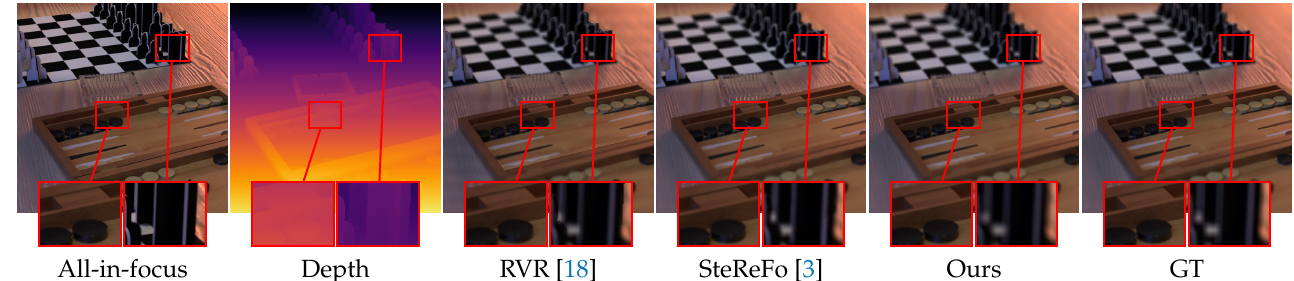
Figure 11. Qualitative results of different DoF rendering methods on the 4DLF dataset. Best viewed zoomed in on-screen.